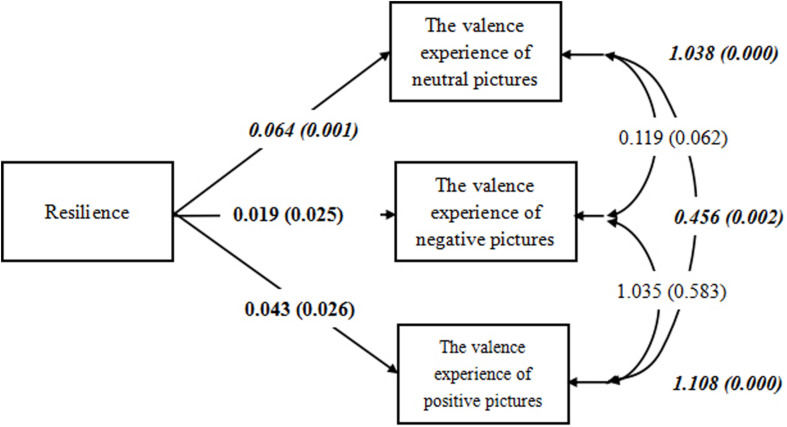
Complete MSEM model of Experiment 1. All results are standardized using the M-Plus SDTXY procedure. Values in bold are significantly different from zero at p < 0.05; values in bold and italics are significantly different from zero at p < 0.01.